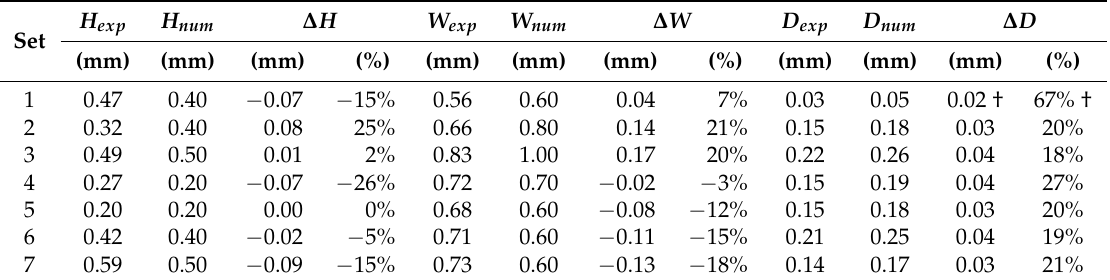
Table 5. Experimental measurements and numerical results for each single track.